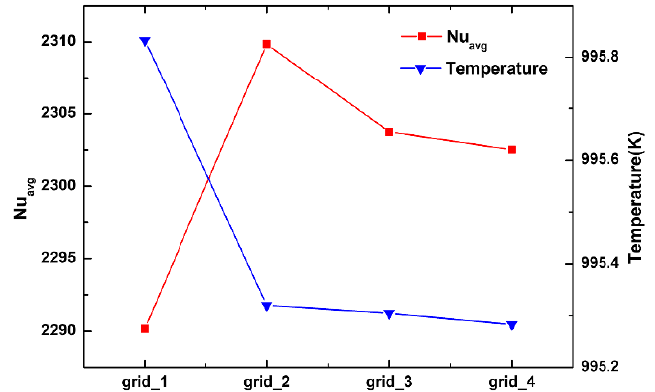
Figure 6. Average temperature and Nusselt number with different grid numbers.